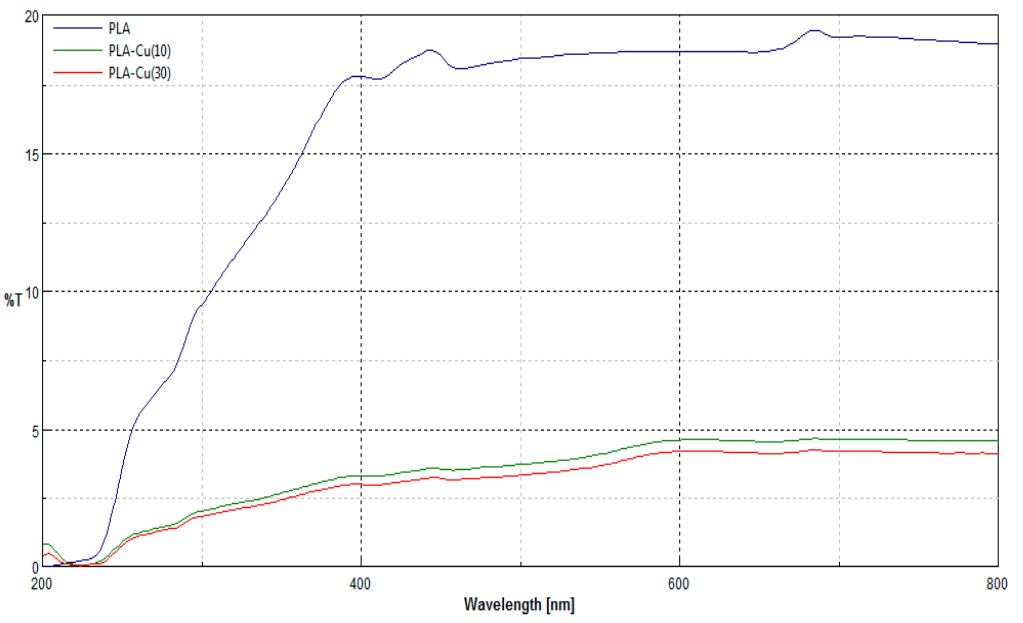
Figure 5. Transmittance spectra of PLA and PLA–Cu 0 (t) hybrids (PLA–Cu 0 (10) and PLA–Cu 0 (30)).